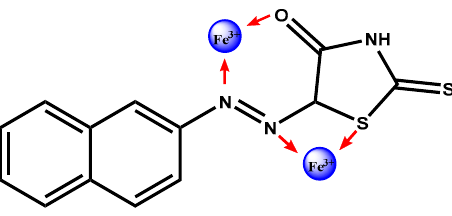
Figure 5. The suggested azo 4c –iron (III) complex structure.